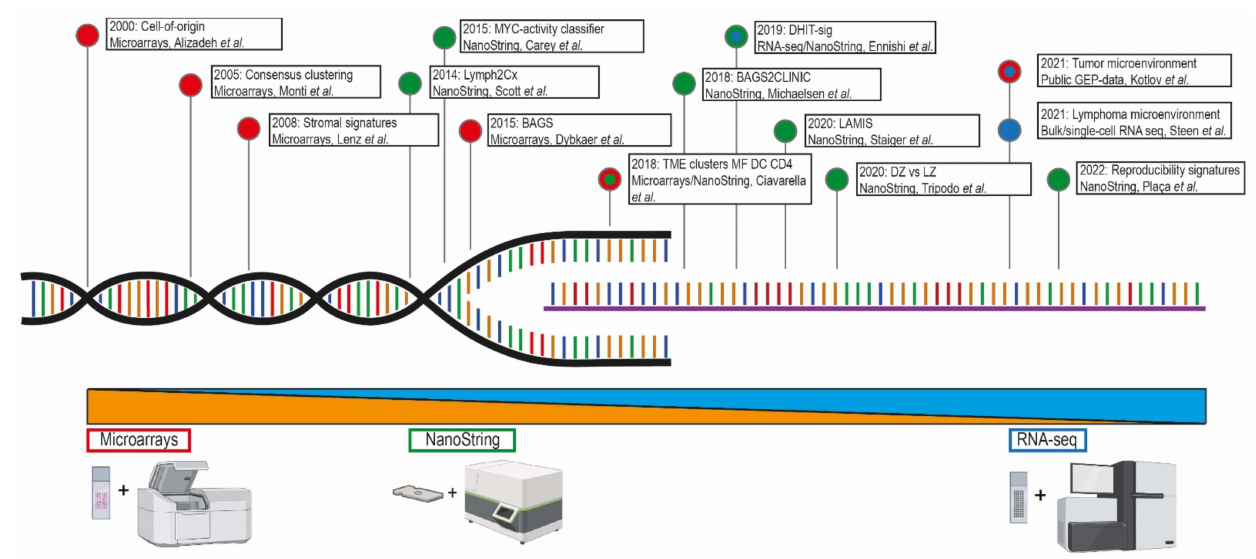
Figure 1. The meaningful arrival of GEP in DLBCL. This timeline presents the implementation of GEP strategies in DLBCL studies throughout the past two decades and marks the relevant findings with their corresponding techniques [7,9–15,17–21]. Within the lymphoma research field, technological advances shifted the approach from microarrays (red) to NanoString (green) and ultimately (single cell) RNA sequencing